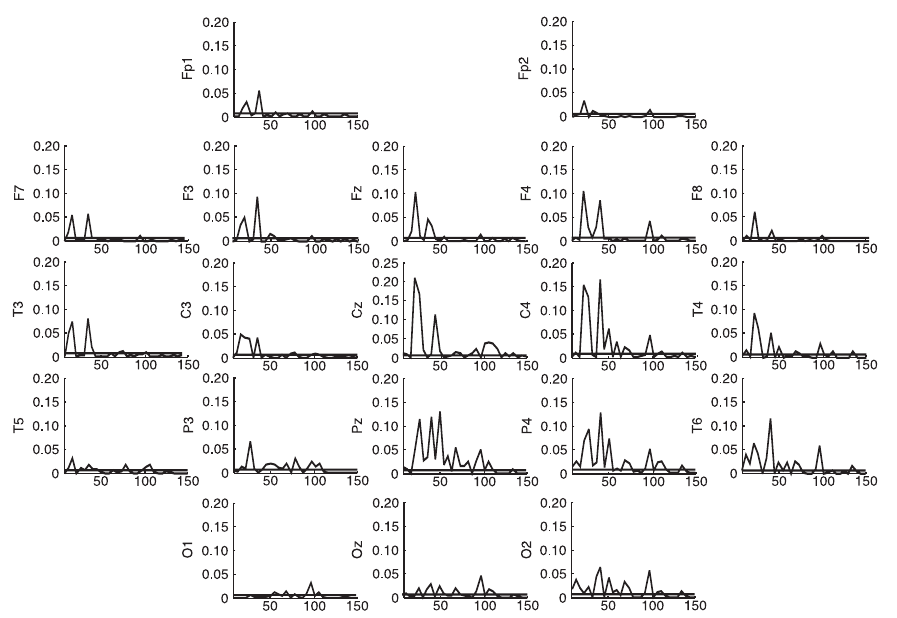
Figure 5. Magnitude-squared coherence (MSC) topography for volunteer #1. The abscissa is the frequency (Hz) and the ordinate is the MSC (dimensionless). Horizontal line is the critical value = 0.006, for α = 5% and M =